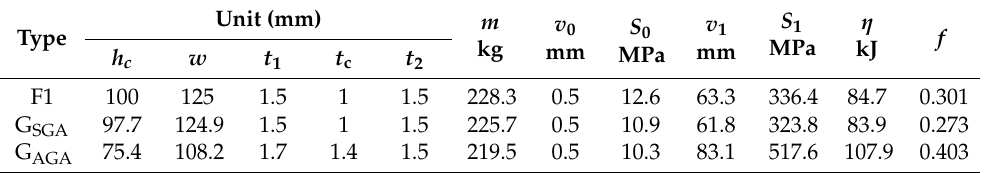
Figure 7. Coupling algorithm optimization based on BP neural network and genetic algorithm. ( a ) Training error map of BP network, and ( b ) fitness curve of the genetic algorithm. Table 6 lists the program optimization results and simulation calculation results for comparison. Table 6. Comparison of optimization algorithm and simulation calculation